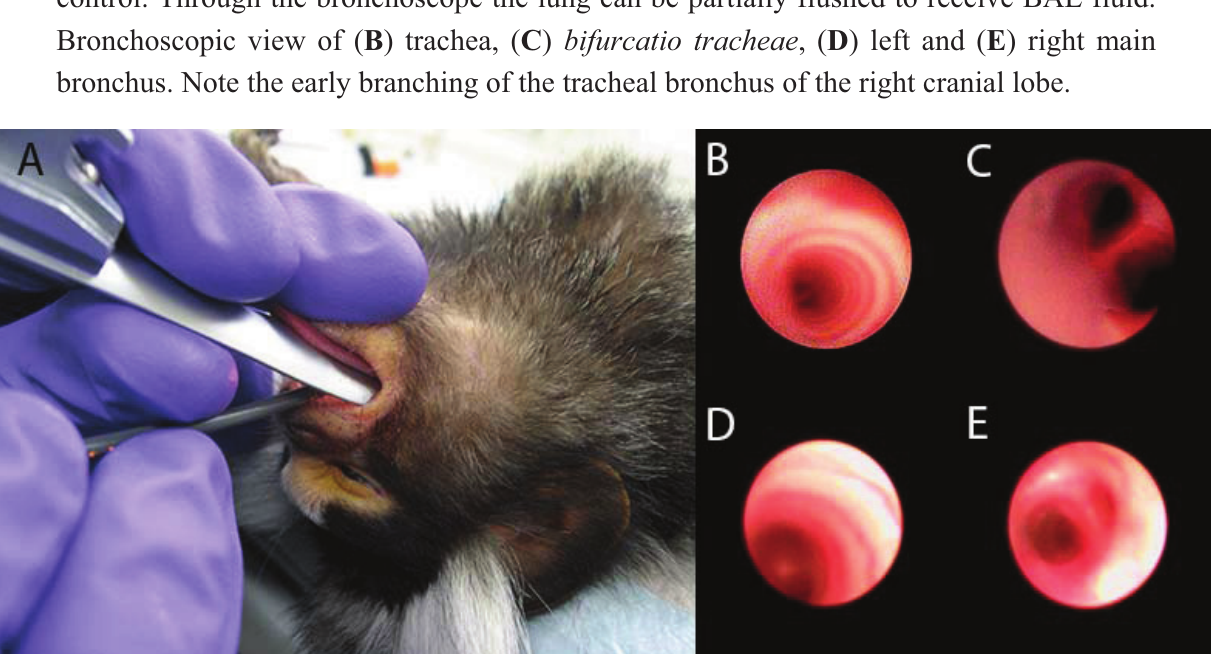
Figure 2. Bronchoscopy, a common respiratory technique, is feasible in